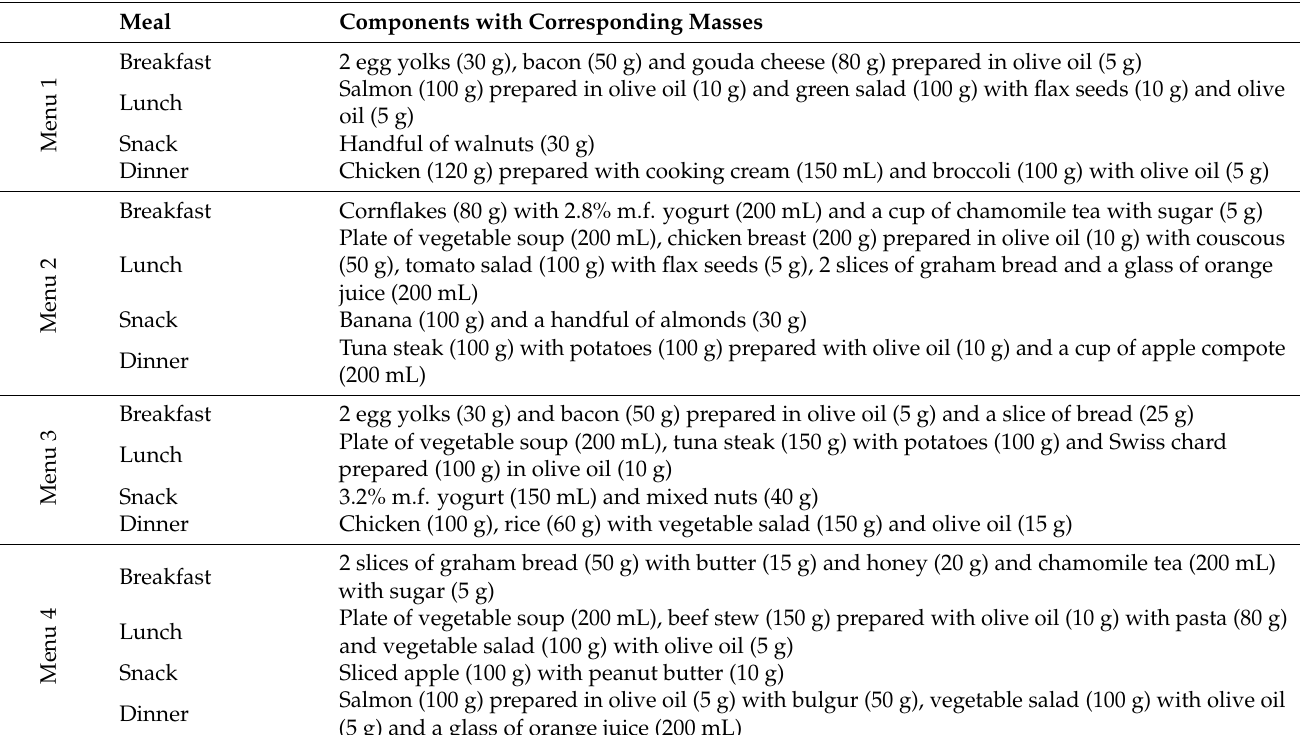
Table 1. Designed meal plans with different proportions of macronutrients with an emphasis on the carbohydrates and